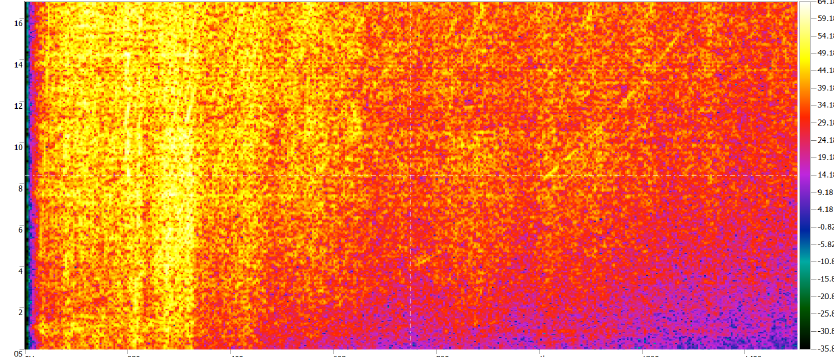
Fig. 8. Noise order analysis of right rear seat passenger's external ear (acceleration